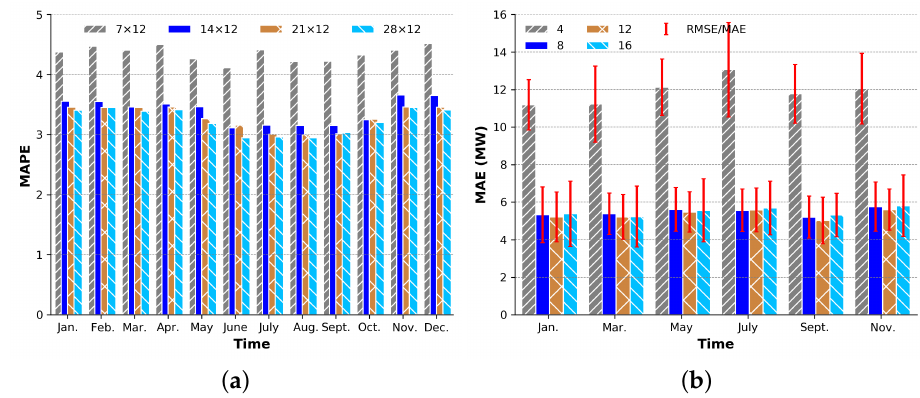
Figure 8. ( a ) Forecast errors of historical load matrices with different sizes. The data are from the PAPER in 2018, and the frame number is eight. ( b ) Influence of different time frames on the forecast results. The data are from the RECO in 2017, and “4, 8, 12, 16” indicate the frame number of the